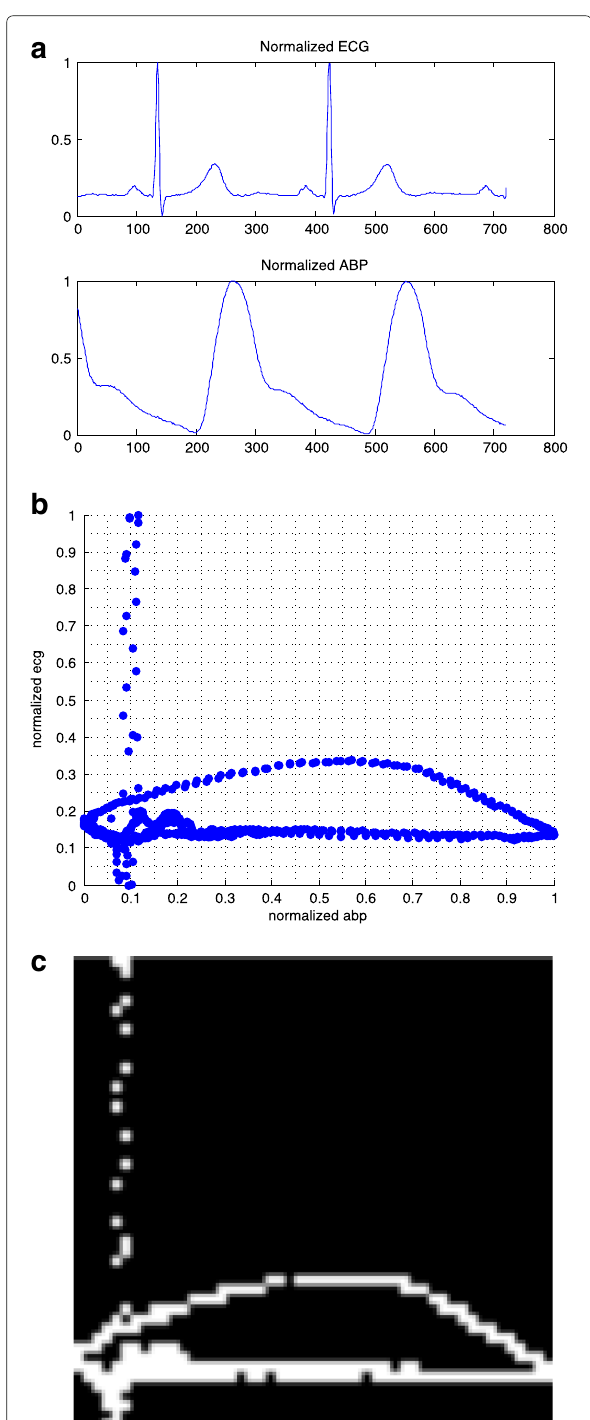
Fig. 8 A negative class image created by ECG and ABP snippets synchronously measured from a user. The top one shows normalized ECG e ( t ) and normalized ABP a ( t ) . The middle one shows a portrait G generated based on e ( t ) and a ( t ) . The bottom one shows a negative class image I